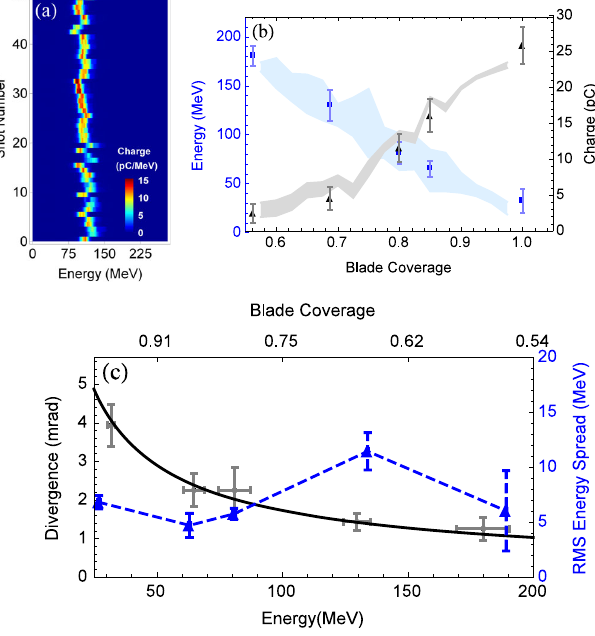
FIG. 3. (a) Energy spectra for 50 consecutive shots when blade coverage is 0.8. (b) Mean energy (blue squares) and charge (gray triangles) of the electron beams versus blade coverage. Exper- imental results are displayed as points and values calculated from measured density profiles are displayed as shaded regions. (c) Divergence (black) and absolute energy spread (blue) versus energy. The experimental values are displayed as points and the γ − 3 = 4 fit as solid line. Note the stable absolute energy spread throughout the range of energies. All error bars represent one standard deviation of FIG. 2. (a) Plasma electron density profile measured along the laser propagation axis for blade coverage 0.575. The densities n n L , and high density length 1 and 2 , the acceleration length acc L have been labeled. The dashed line shows the region that high cannot be Abel inverted. Pre-Abel inverted wavefront images were used to measure the length of the downramp. The imaging resolution of the wavefront sensor is 35um. Inset shows the two regions for which the Abel inversion was performed. (b) Density lineouts as the blade was translated through the gas jet. Each horizontal line corresponds to a density lineout at a particular blade coverage. Blade coverage of 1 corresponds to the blade completely covering the jet exit. (c) Peak density n 1 (red), plateau density n 2 (blue), and plateau density length L (black) for the acc blade coverages used to produce electron beams.